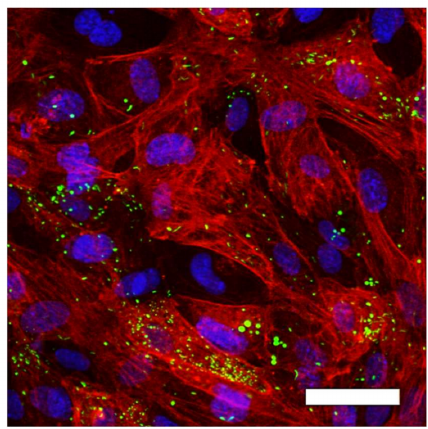
Figure 8. Proof of HUVEC identity by immune fluorescence staining of von Willebrand factor (vWF) expression (green) within adherent HUVEC culture. HUVEC were further stained with DAPI (genomic DNA, blue) and α -SMA (cytoskeleton, red). Picture was taken by cLSM in 20-fold primary magnification; scale bar: 50 µ